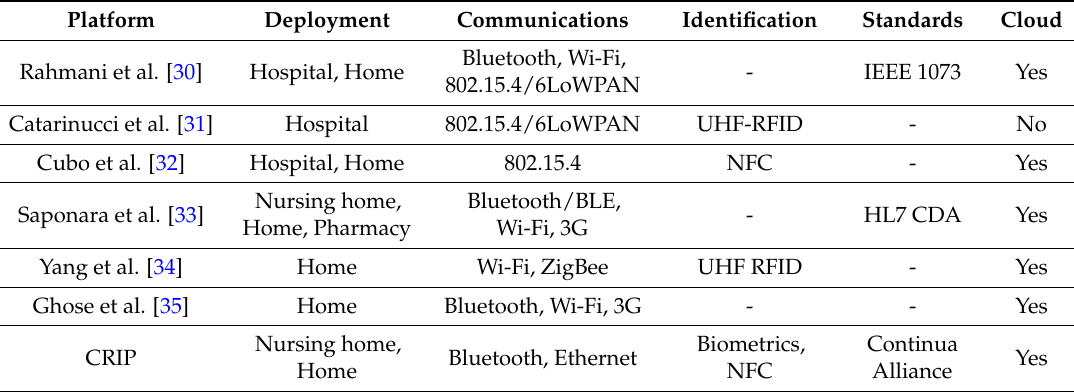
Table 1. Resume of the deployment scenarios and technologies used of the presented